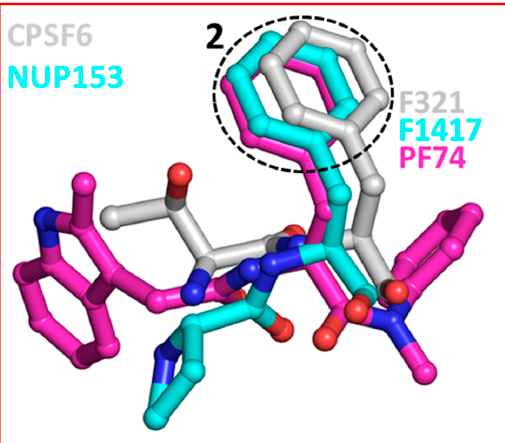
Figure 4. Superposition of CPSF6, NUP153 and PF74. The dotted circle highlights the equivalent position of phenylalanine residues in CPSF6 and NUP153 and one of the two phenyl rings of PF74. The equivalent ring structure in GS-CA1 and GS-6207 is difluorobenzene, which is not shown in this figure. The structures of capsid inhibitors shown here have either been solved or in complex with capsid.